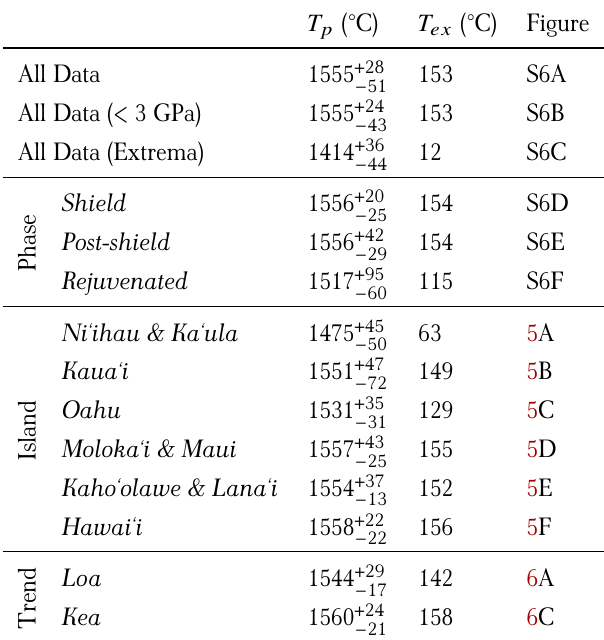
Table 3: Estimated potential and excess temperatures ( T p and T ex , respectively) for Hawaiian Islands. Extrema calculates thermobarometric conditions using H and Fe +3 / Σ Fe =